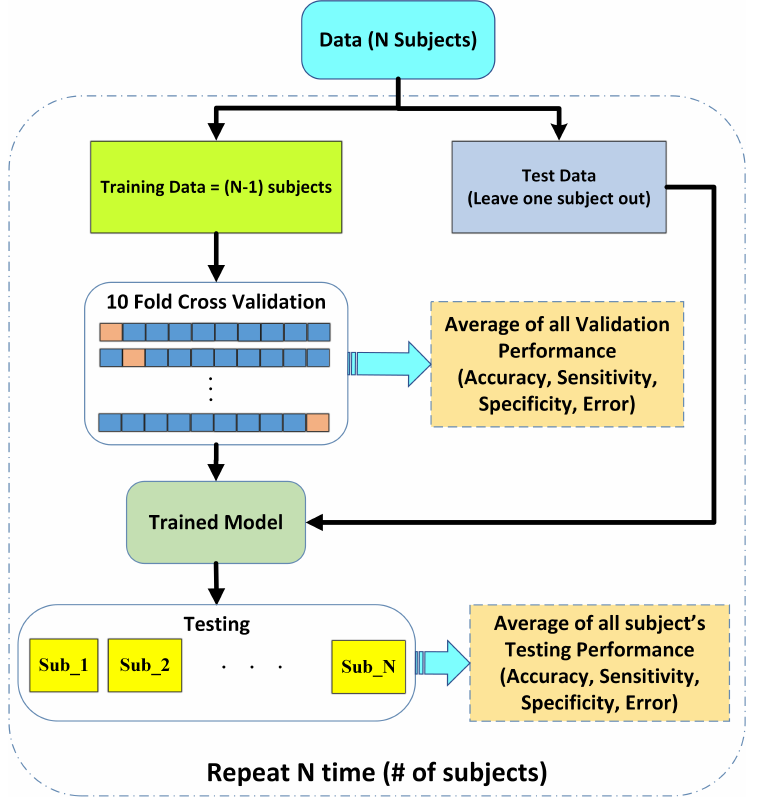
Figure 4. Performance evaluation scheme using leave one subject out cross validation